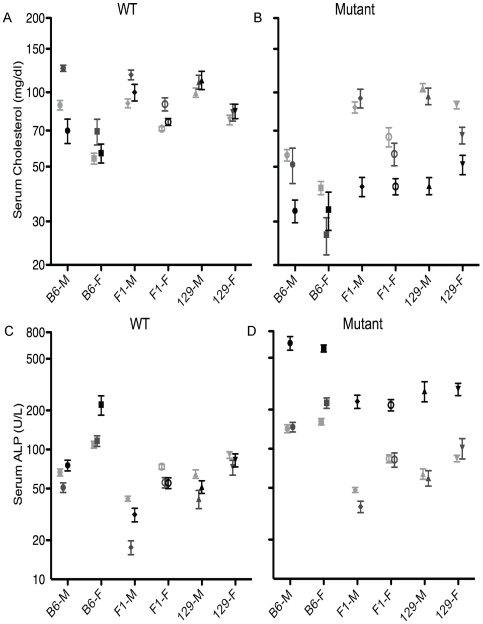

Atp8b1 mutation results in lowered serum cholesterol and increased serum alkaline phosphatase (sALP) levels in B6 mice.Serum cholesterol and alkaline phosphatase levels in WT (A, C) and mutant (B, D) mice of B6, 129, and F1 backgrounds at baseline (light grey) and after feeding of cholate (black) or control (medium grey) diet for 4–8 days; means and SEM are shown. N's at baseline: B6 (n = 7−15), 129 (n = 42−66), and F1 (n = 21−36); N's for cholate diet: B6 (n = 5−12), 129 (n = 15−29), and F1 (n = 6−19) and for control diet: B6 (n = 5−12), 129 (n = 18−29), and F1 (n = 11−18).